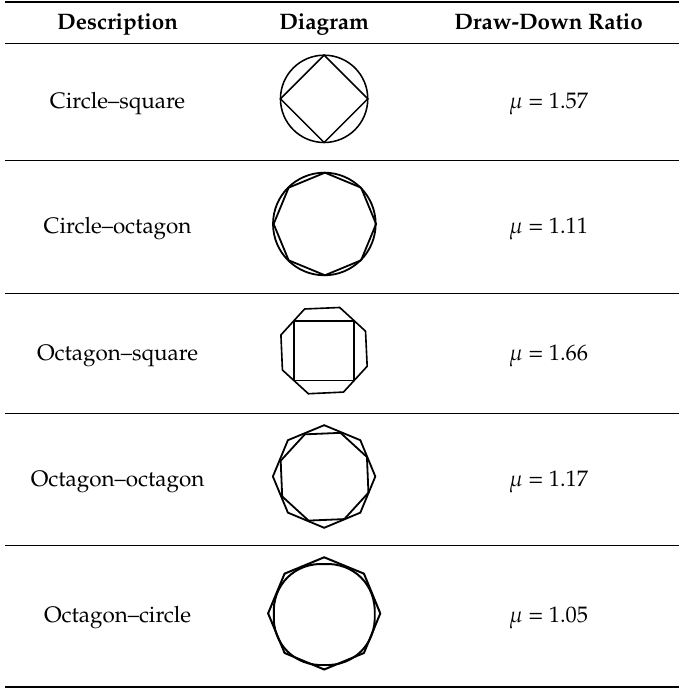
Figure 2. Production equipment layout diagram: 1, 2—Decoilers (reel or coil); 3—Stretcher/Feeder; 4—Welding Unit; 5—Accumulator; 6—Inductor; 7—Mill Stands; 8—Actuating Units; 9—Cooling Sections; 10—Winder. Table 1. Four-Roll Pass systems.